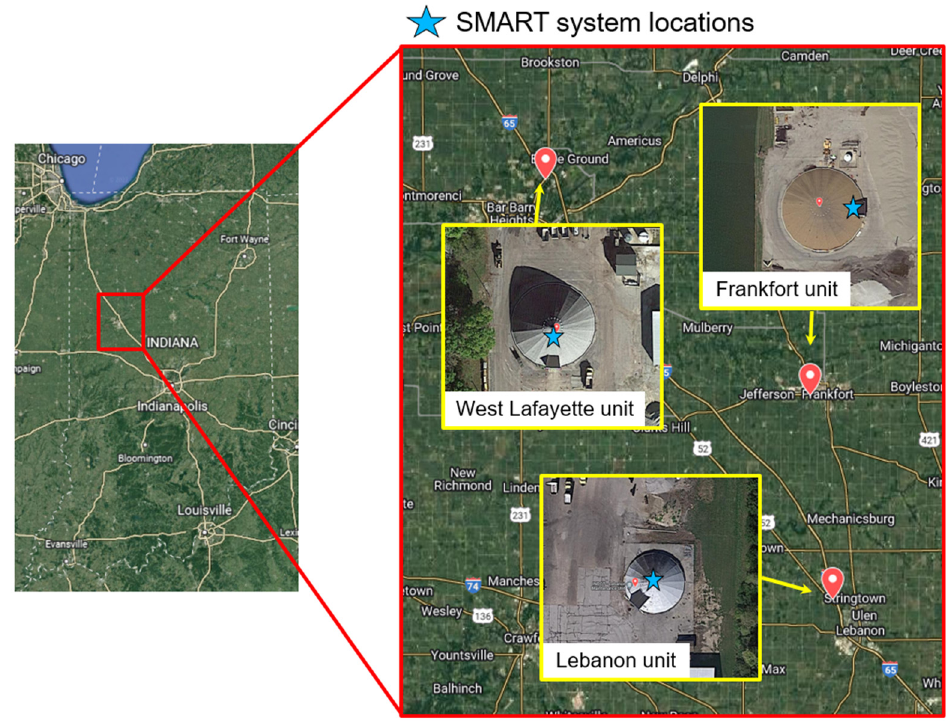
Figure 6. Locations of the three salt dome facilities used in this study along with a sample aerial view of each facility (aerial photo adopted from Google Earth Image). Table 1. Data collection sites, facility size, number of scans, and system location.